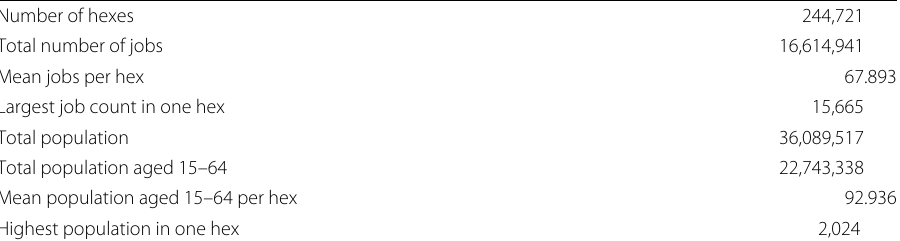
Table 1 Summary of the population and employment data used in our analysis